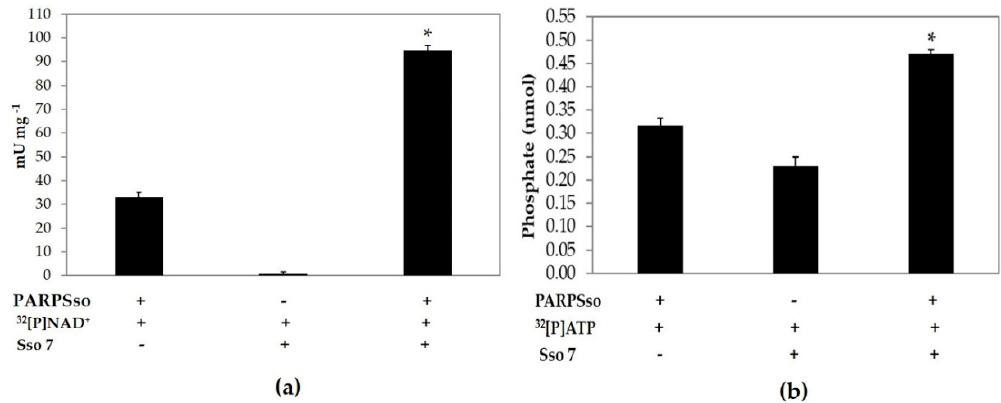
Figure 4. Sso7 effect on polymerase and ATPase activity of thermozyme. ( a ): Polymerase activity was assayed in standard condition, as reported in § 2.5 by incubating: (i) purified PARPSso (10 μ g); (ii) purified Sso7 (10 μ g); (iii) purified PARPSso (10 μ g) in presence of purified Sso7 (10 μ g). ( b ): ATPase activity was assayed as described in § 2.6 by incubating: (i) thermozyme (10 μ g); (ii) Sso7 (10 μ g of proteins); (iii) purified thermozyme (10 μ g) in presence of purified Sso7 (10 μ g). The values were the means of four different experiments in duplicate. The significance differences (*: p < 0.05) were tested with the Mann–Whitney U test [24].